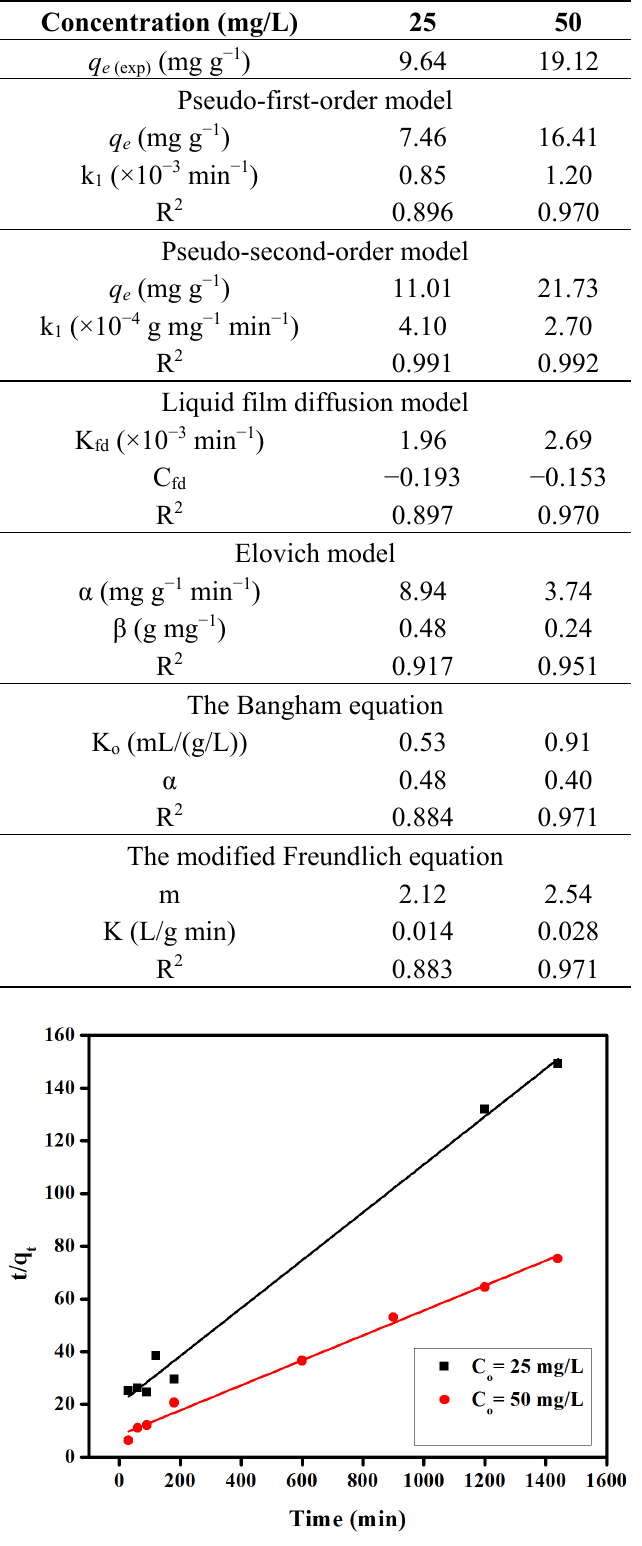
Table 1. Kinetic parameters for the effect of concentration on the adsorption of CR onto anion exchange membrane (EBTAC).